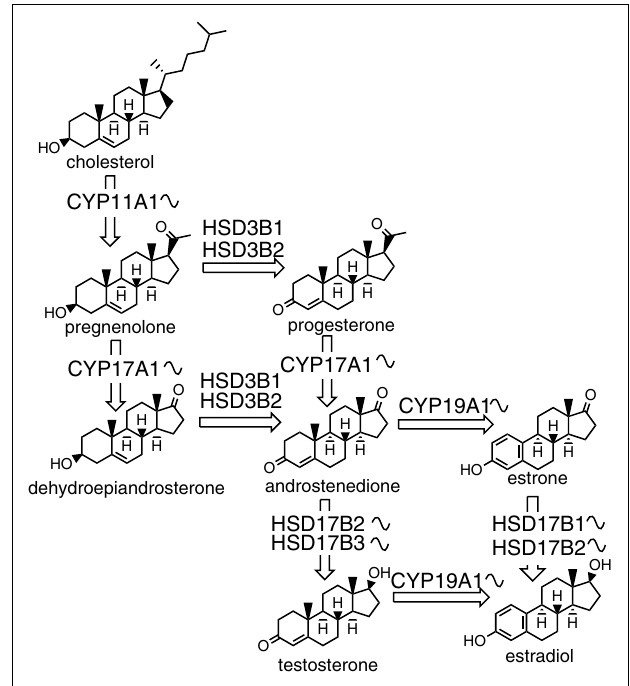
FIGURE 2 |The biosynthesis of sex steroids .The sinusoid curve next to an enzyme depicts its known circadian expression.The synthesis starts with cholesterol and consists of several steps catalyzed by either enzymes from the cytochrome P450 or hydroxysteroid dehydrogenase